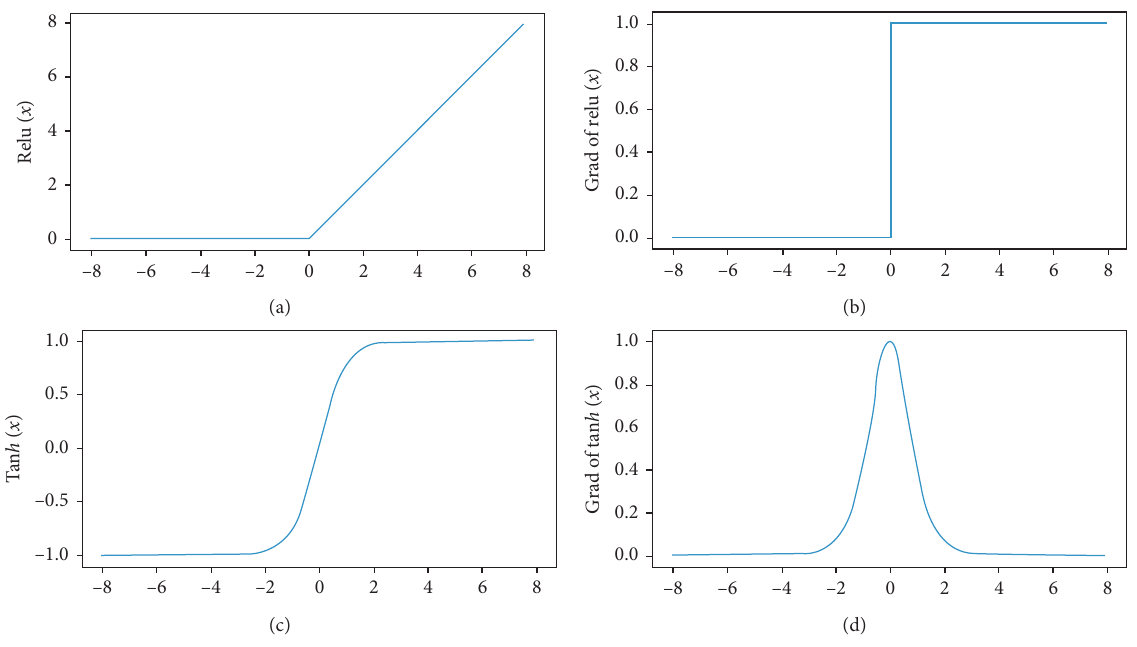
Figure 4: Comparison between ReLU function and tanh function.